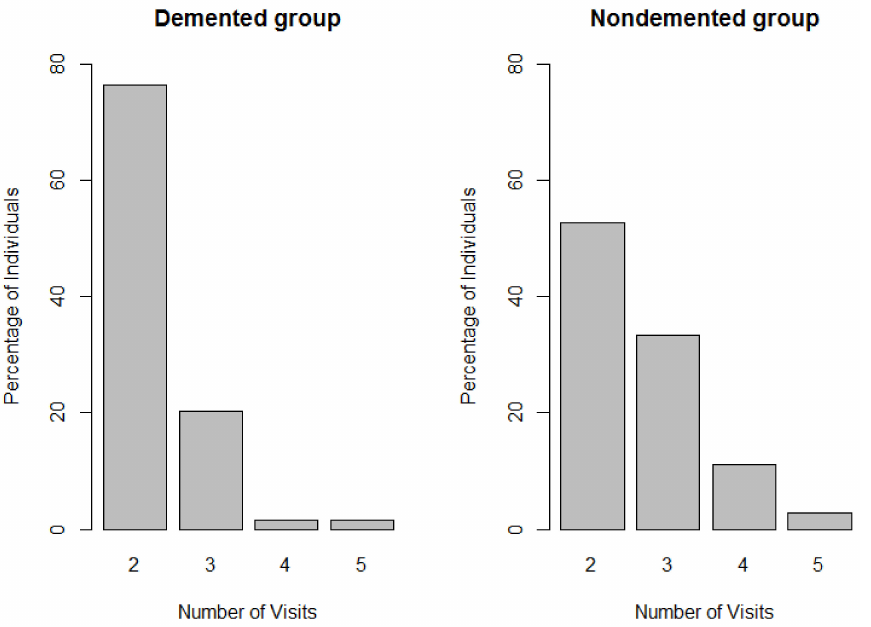
Figure 1. Plot showing distribution of the number of visits in the demented group and the nonde- mented group of